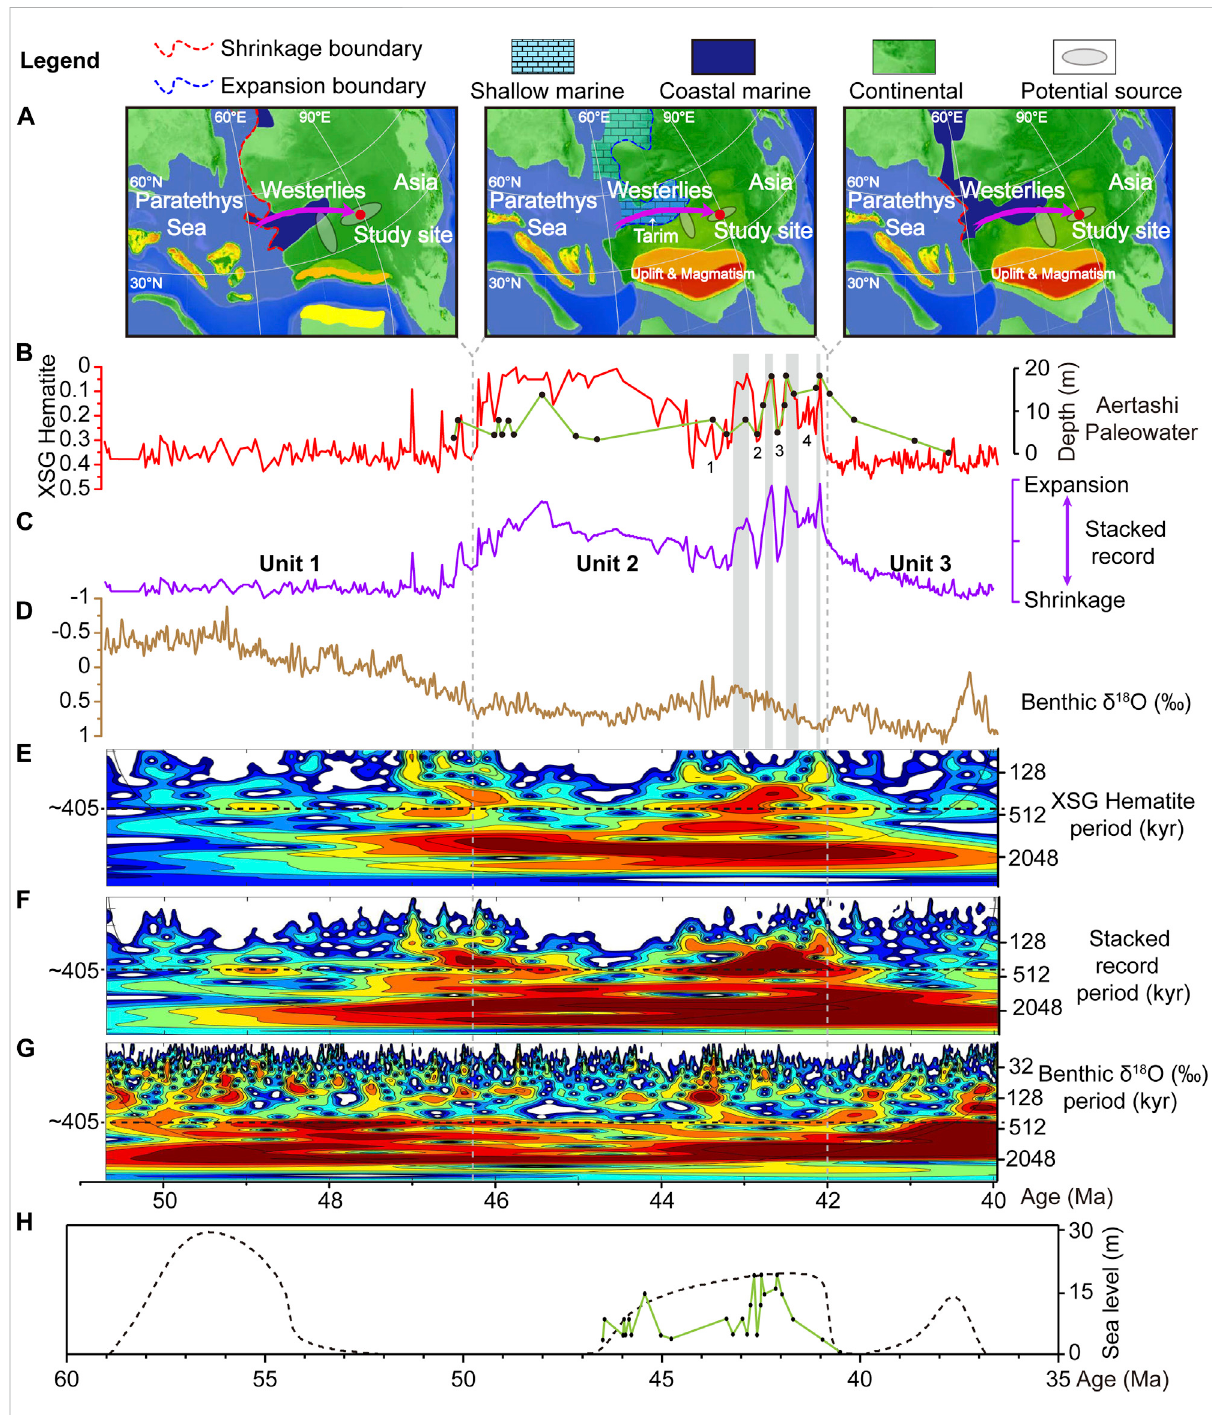
FIGURE 4 Schematic illustration of the relationship between the Paratethys Sea expansion/shrinkage, global climate, dust source area, and the hematite content variations in the studied section in different intervals. (A) The generalized middle to late Eocene paleogeography of Asia is modi fi ed from Kaya et al. (2019) and Meijer et al. (2019). The paleo-location of the Xishuigou section is shown with a red dot, which was reconstructed using the open-sourceGplateplatformcitingreference. (B) ThehematiterecordfromtheXishuigousectioncomparedtopaleowaterdepthcurveforthe Aertashi section of Kaya et al. (2019). (C) Stacked expansion/shrinkage record of the Paratethys Sea derived from stacking the hematite content and paleowater depth records in (B) . The hematite content and paleowater depth records were interpolated linearly at 20 ka intervals and normalized to 0 – 1. Then, the hematite content and paleowater depth records were averaged to form a stacked expansion/shrinkage record of the Paratethys Sea. Gray bars highlight the Paratethys Sea expansion during ~44 – 42 Ma. (D) Benthic oxygen isotope record (10 point running averaging) (Westerhold etal.,2020). (E – G) WaveletanalysisofthehematitefromtheXishuigousection,stackedrecord,andbenthicoxygenisotopebetween~51and40 Ma, respectively. (H) Previous sea level record of the Paratethys Sea during ~60 – 35 Ma is re fl ected by the black dotted line (Kaya et al., 2019) and the paleowater depth record during 46.5 – 40.5 Ma is shown by the light green solid